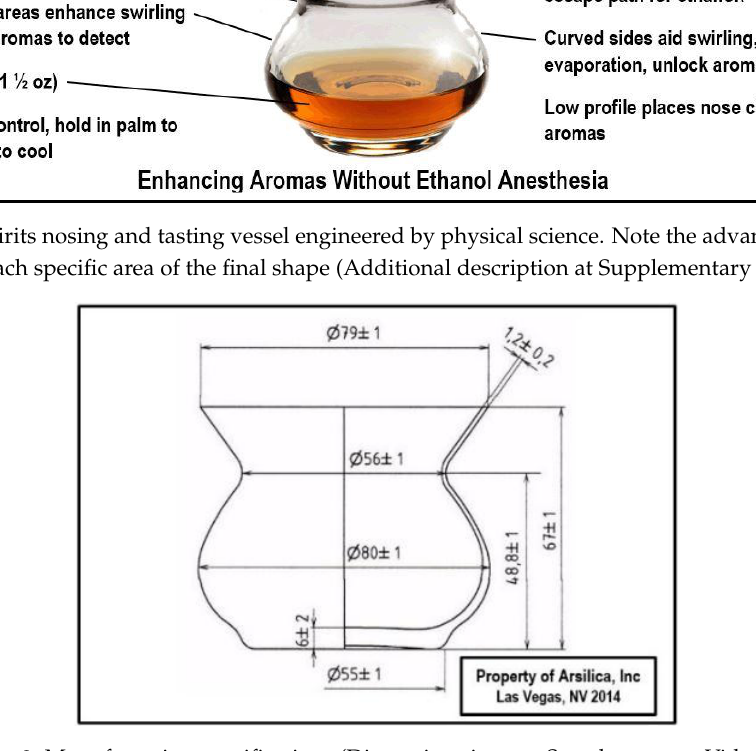
Figure 9. Manufacturing specifications (Dimensions in mm, Supplementary Video S3).